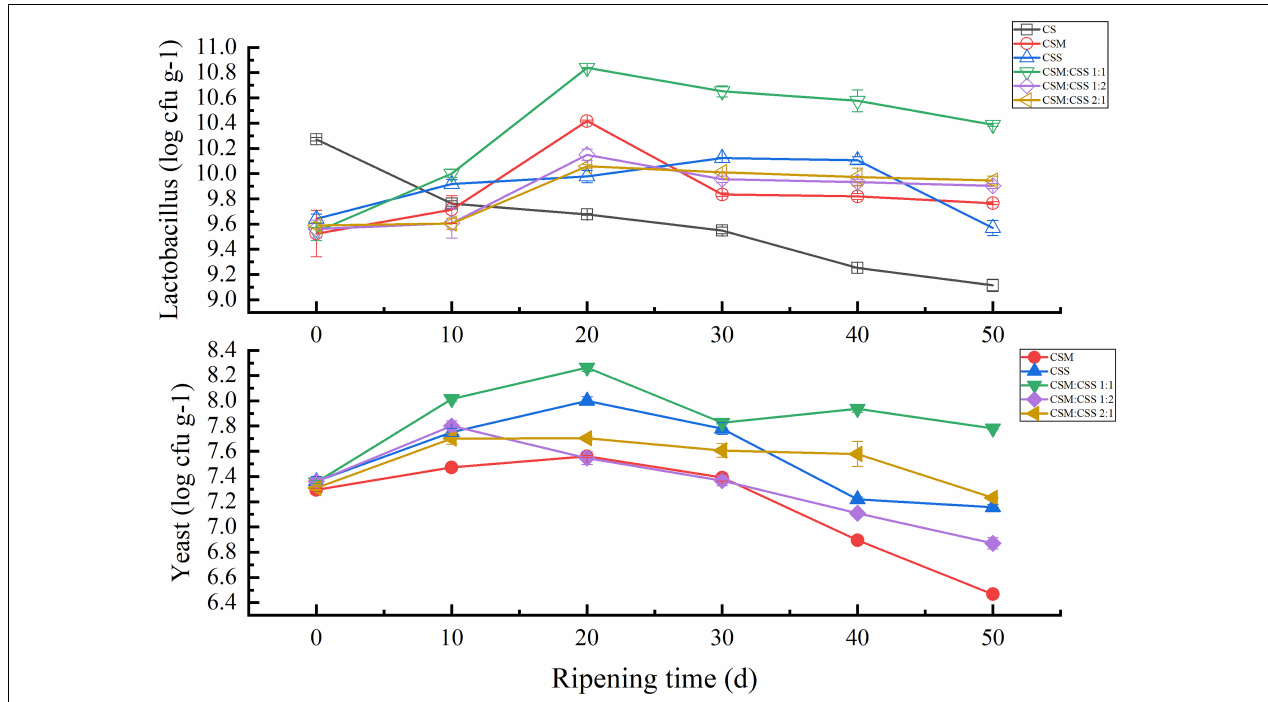
FIGURE 1 | Comparative analysis of the microorganism content of the cheeses. CS, CSM, CSS, CSM:CSS 1:1, CSM:CSS 1:2 and CSM:CSS 2:1 represent cheeses fermented using the commercial starter (Control group), K. marxianus B13–5, S. cerevisiae DL6–20, K. marxianus B13–5: S. cerevisiae DL6–20 1:1, K. marxianus B13–5: S. cerevisiae DL6–20 1:2, and K. marxianus B13–5: S. cerevisiae DL6–20 2:1. Error bars indicate standard